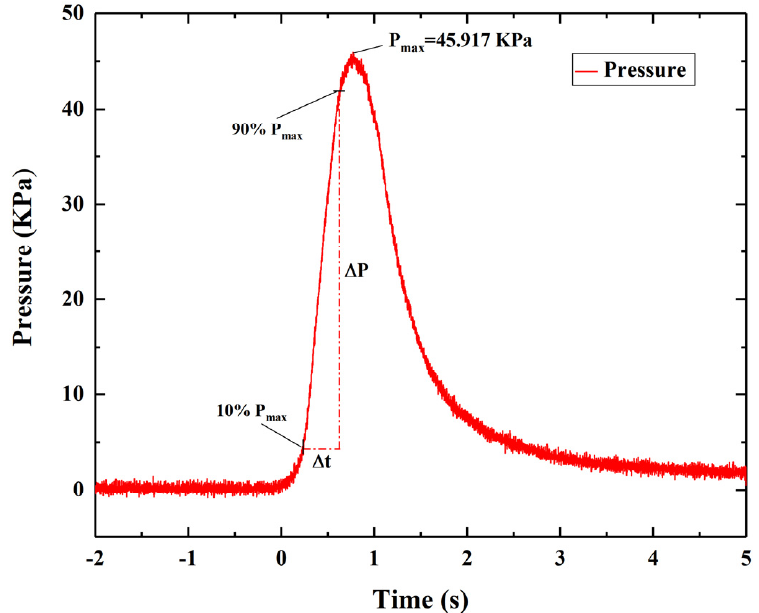
Figure 14. Pressure-time curve of the sample.